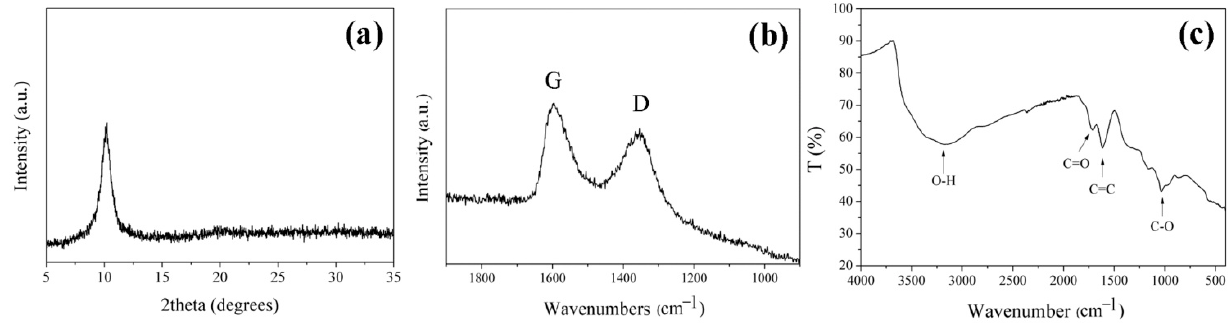
Figure 1. ( a ) XRD pattern, ( b ) Raman, and ( c ) FTIR spectra of graphene oxide